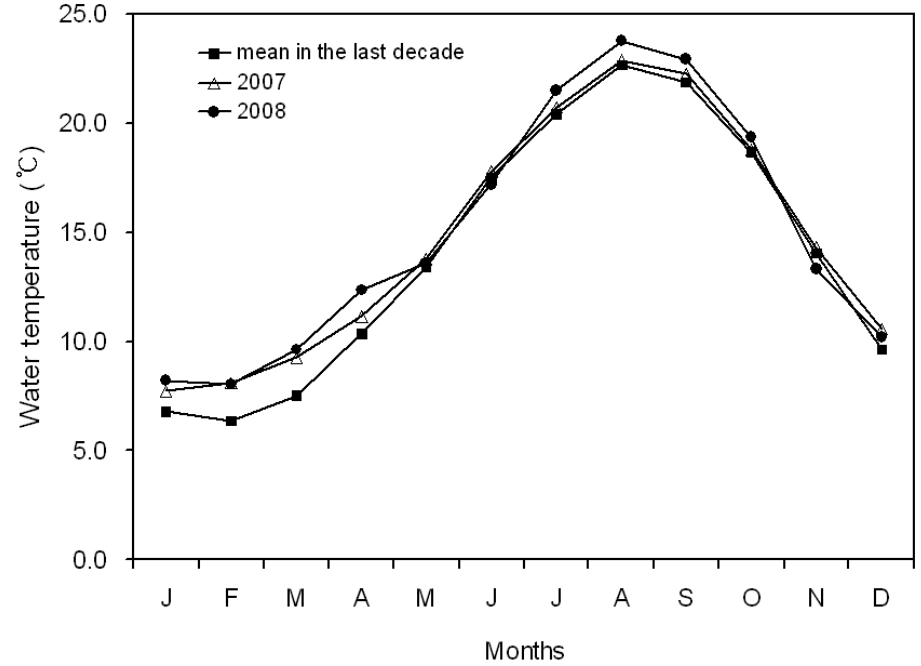
Figure 3. Monthly variations in the mean water temperature during the study period (2007–2008) in the coastal waters of Yangyang and between 1999 and2008 in the coastal waters of Sokcho.